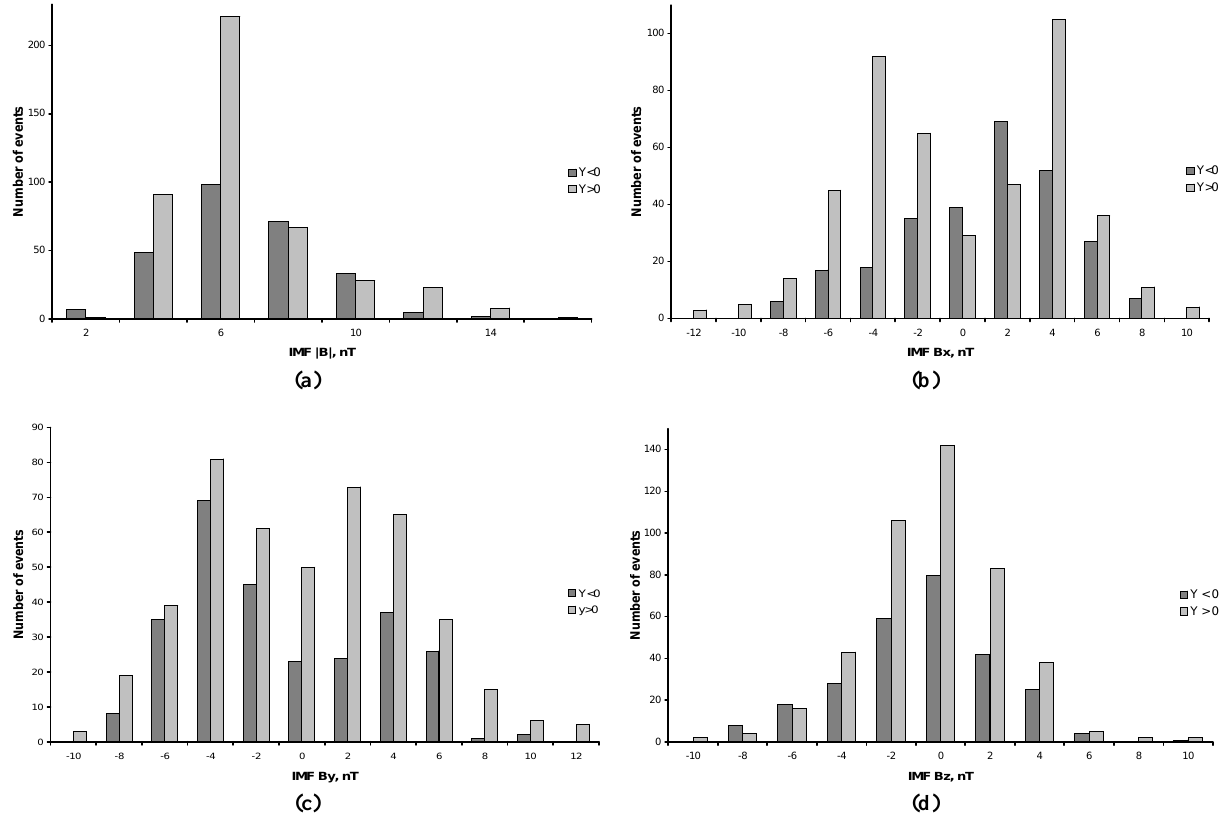
Fig. 6. Histograms of averaged magnetic field strength (a) and three (b–d) components for the events at the dusk and dawn magnetosheath (in the GSE coordinate